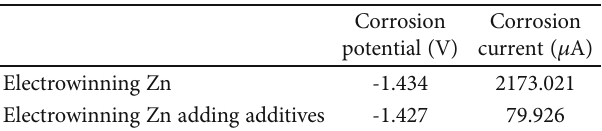
Figure 6: (a) The fl oat charge process of LiMn collectors by electrowinning with or without additives. Table 2: The corrosion potential and corrosion current of di ff erent zinc